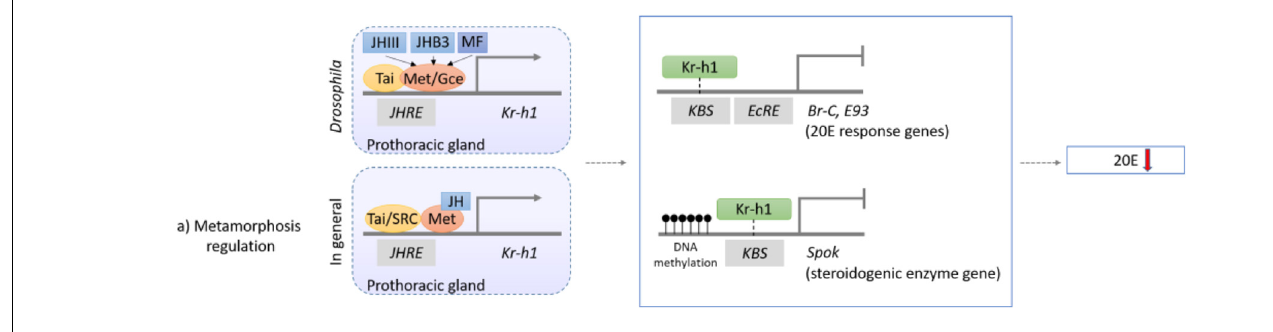
FIGURE 3 | Schematic diagram showing the mechanism of sesquiterpenoids in metamorphosis regulation in Drosophila and other insects. In fly Drosophila , JH-III, JHB3, and MF will bind to the JH receptor Met or Gce, while in other insects, JH-III will bind to Met in other insects (for details, please refer to text). The complex will then further dimerize with Tai and bind to specific JHRE to initiate the expression of Kr-h1 . Kr-h1 protein will then bind to the KBS to inhibit expressions of 20E response genes ( Br-C and E93 ), and will also bind to KBS and initiates DNA methylation of a steroidogenic enzyme gene Spok , which will all result in the lower titer of 20E and inhibition of metamorphosis.